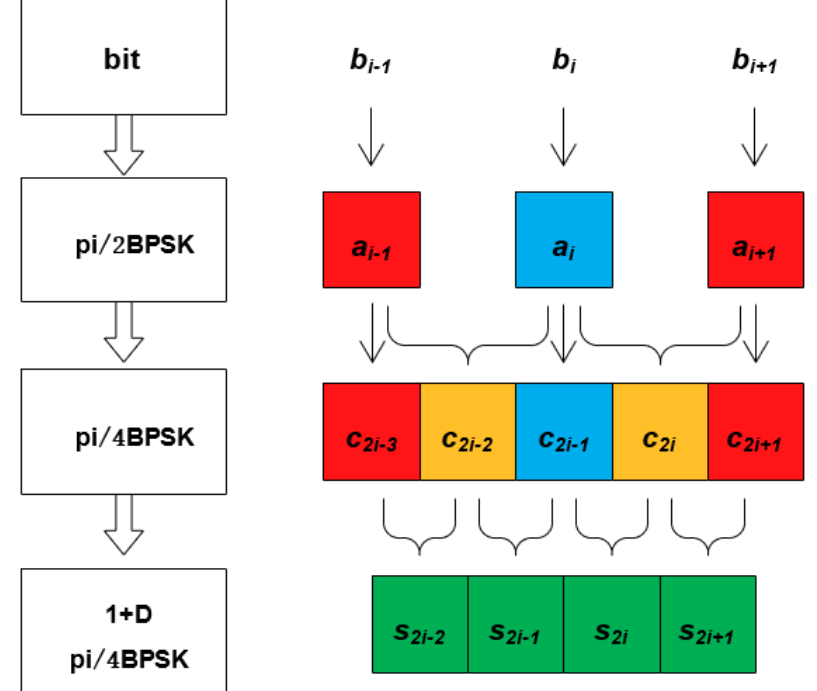
Figure 5. 1 + D pi/4 BPSK modulation process.